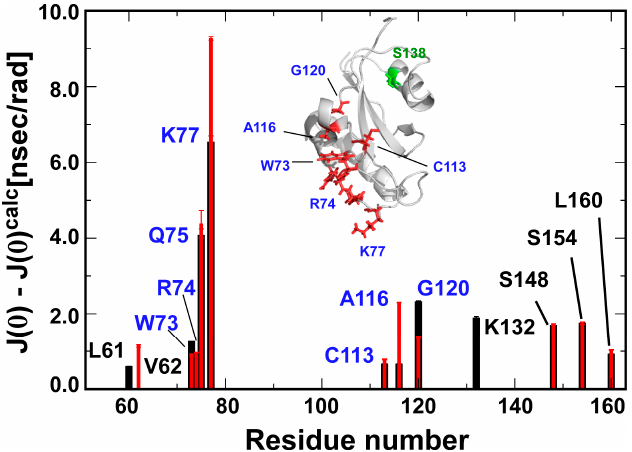
Figure 5. Residue-wise differences between the experimentally obtained J (0) and the calculated J (0) ( J (0) calc ) are shown; only the residues outlying over the theoretical curve are considered (Figure 4). The definition for J (0) calc is described in the main text. The differences for the wild-type and S138A mutant are shown in black and red, respectively. Residues with allosteric changes induced by S138A mutation are labeled. The structural positions for these residues and S138 are modeled in the wild-type Pin1-PPIase structure [13] as red and green sticks, respectively. Residues focused in the text are marked in blue, which residues are also marked on the solution structure of the S138A mutant PPIase domain (inset).